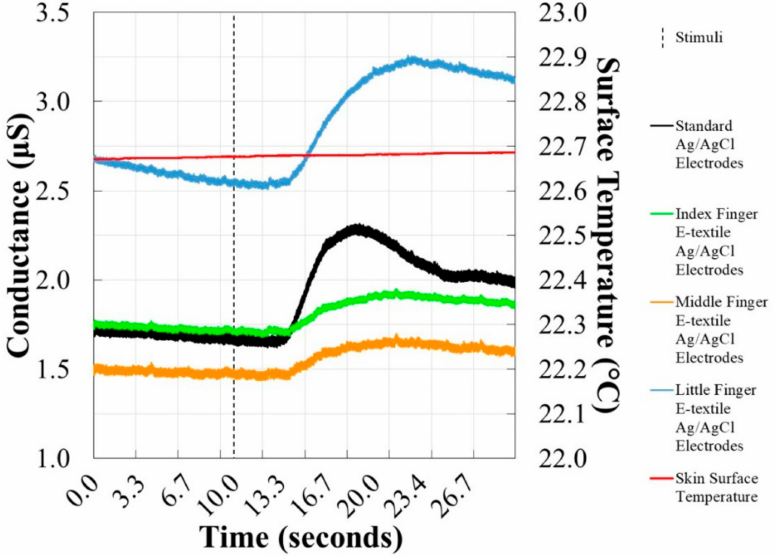
Figure 6. Example EDA stimulus response shown by conductance (primary y -axis) for dry e-textile electrodes (0.12 cm 2 surface area, 0.40 cm distance) at the distal phalanx of the index, middle, and little fingers compared to dry commercial electrodes (1.00 cm 2 surface area, 1.50 cm distance) on the proximal and medial phalanges of the middle finger. Skin surface temperature is also shown (secondary y